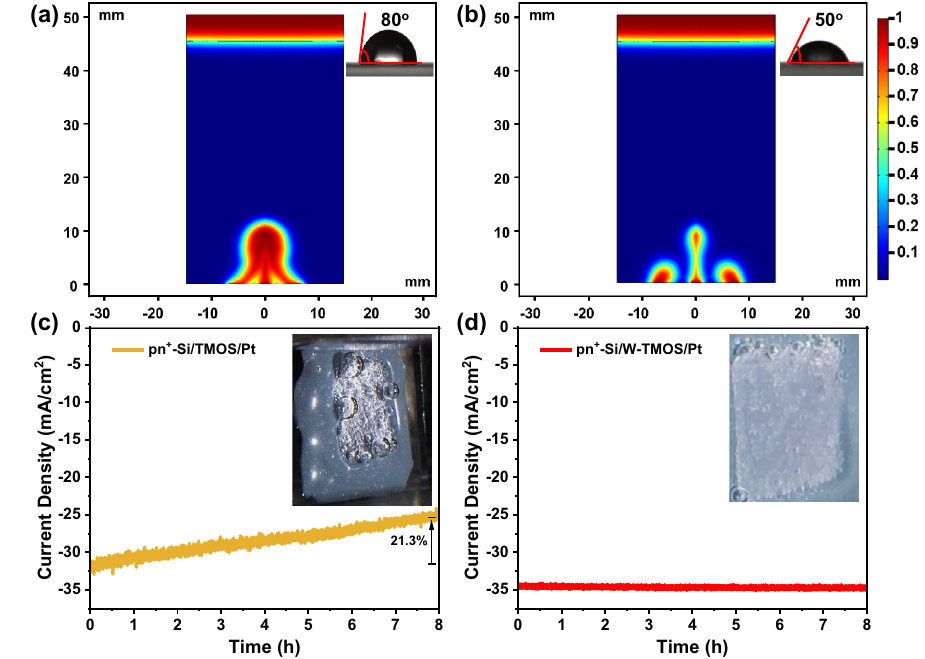
Fig.4|BubbleevolutionprocessandcurrentdroponorganicTMOSprotective layers. Simulation results of bubble growth of a Si/TMOS, and b Si/W-TMOS electrode.(Inset:Contactangle).ThecolorbarshowsthevolumefractionofH 2 gas